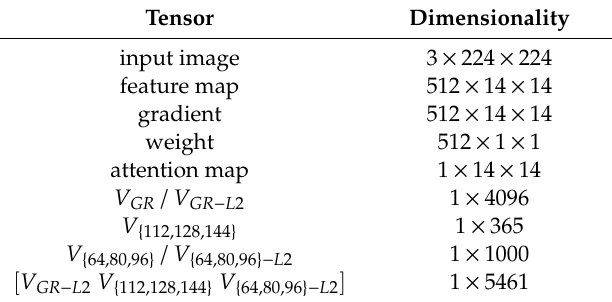
Table 1. The tensor dimensionalities in the processing pipeline.